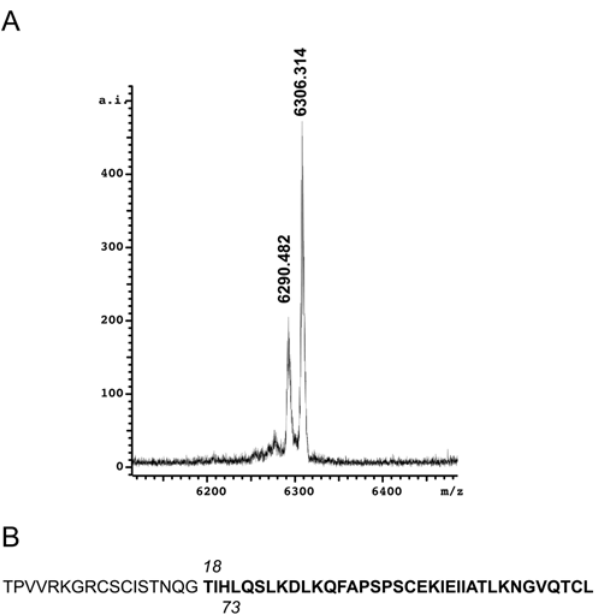
Figure 4. CXCL9 is trimmed amino-terminally and carboxy- terminally by SpeB. Panel A: SpeB-processed CXCL9 was analyzed by MALDI-TOF mass spectroscopy. Masses in Dalton are indicated above the to main intensity peaks. Panel B: The primary sequence of mature CXCL9 with the proposed SpeB-generated fragment constituting amino acids 18–73 in bold. The potentially oxidized tryptophan at position 67 is underlined.